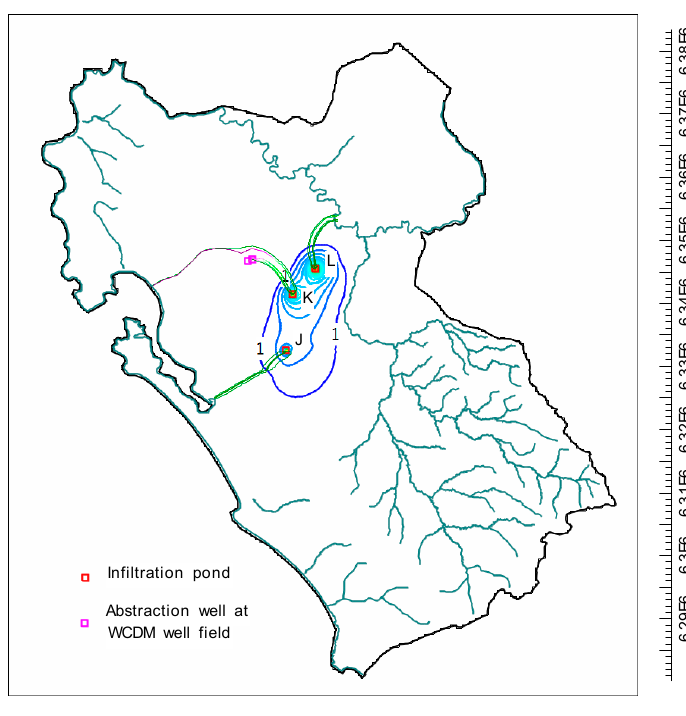
Figure 13. Simulated rise in groundwater level and the flow paths of recharged water in Scenario 2. The unit of rise in groundwater contours is in meters (m), and the interval of contours is 1 m. The color of flow paths indicates the flow time: the greener the flow path, the shorter the flow time; and the more purple the flow path, the longer the flow time.